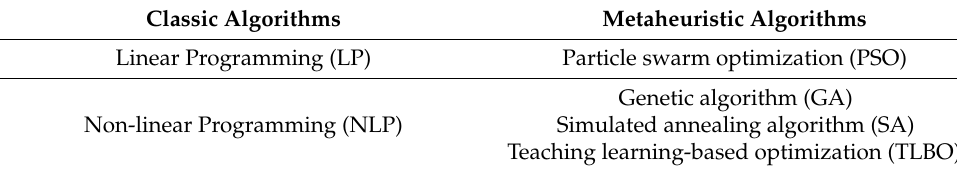
Figure 4. Selected literature on demand response categorized by sectors. Table 2. Classification of DR optimization algorithms according to